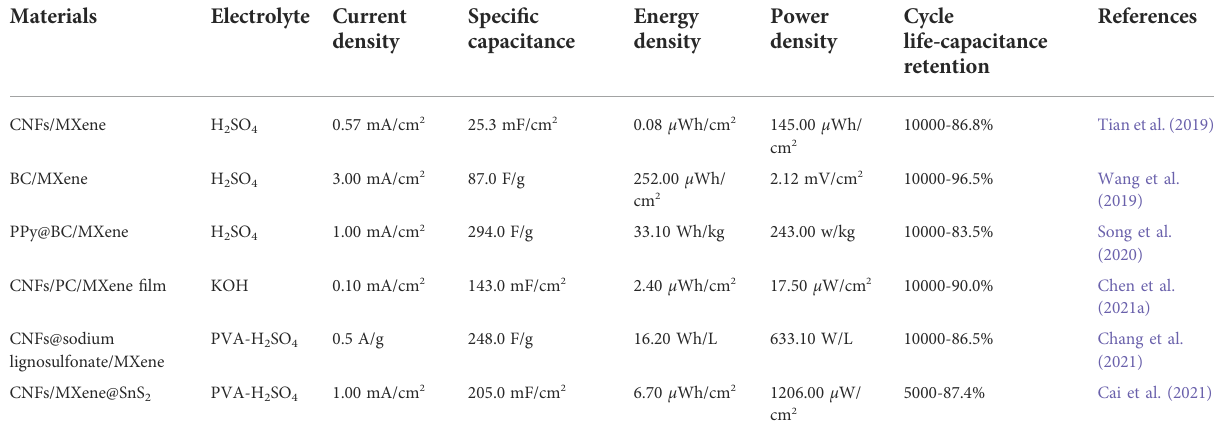
TABLE 1 Electrochemical performance of the nanocellulose/MXene-based supercapacitors.